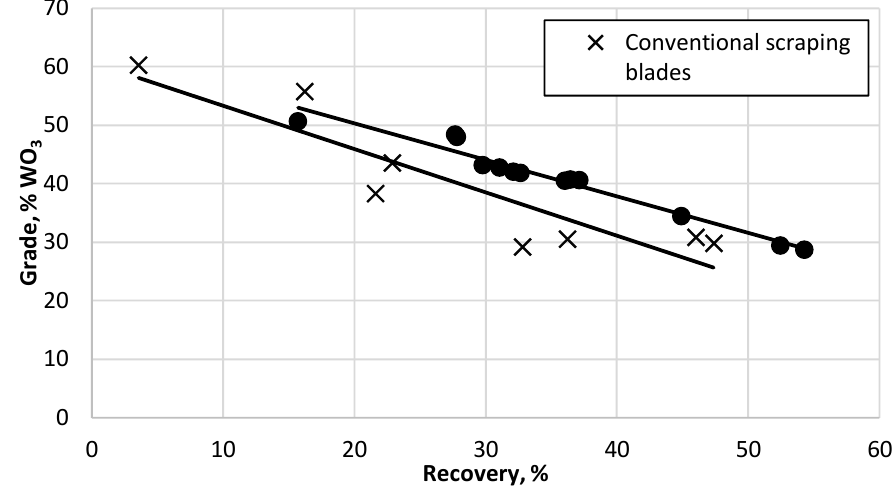
Figure 17. Grade-recovery plot for comparable data points of low profile and conventional scraping blade tests. The solid lines indicate the fitted regression lines.